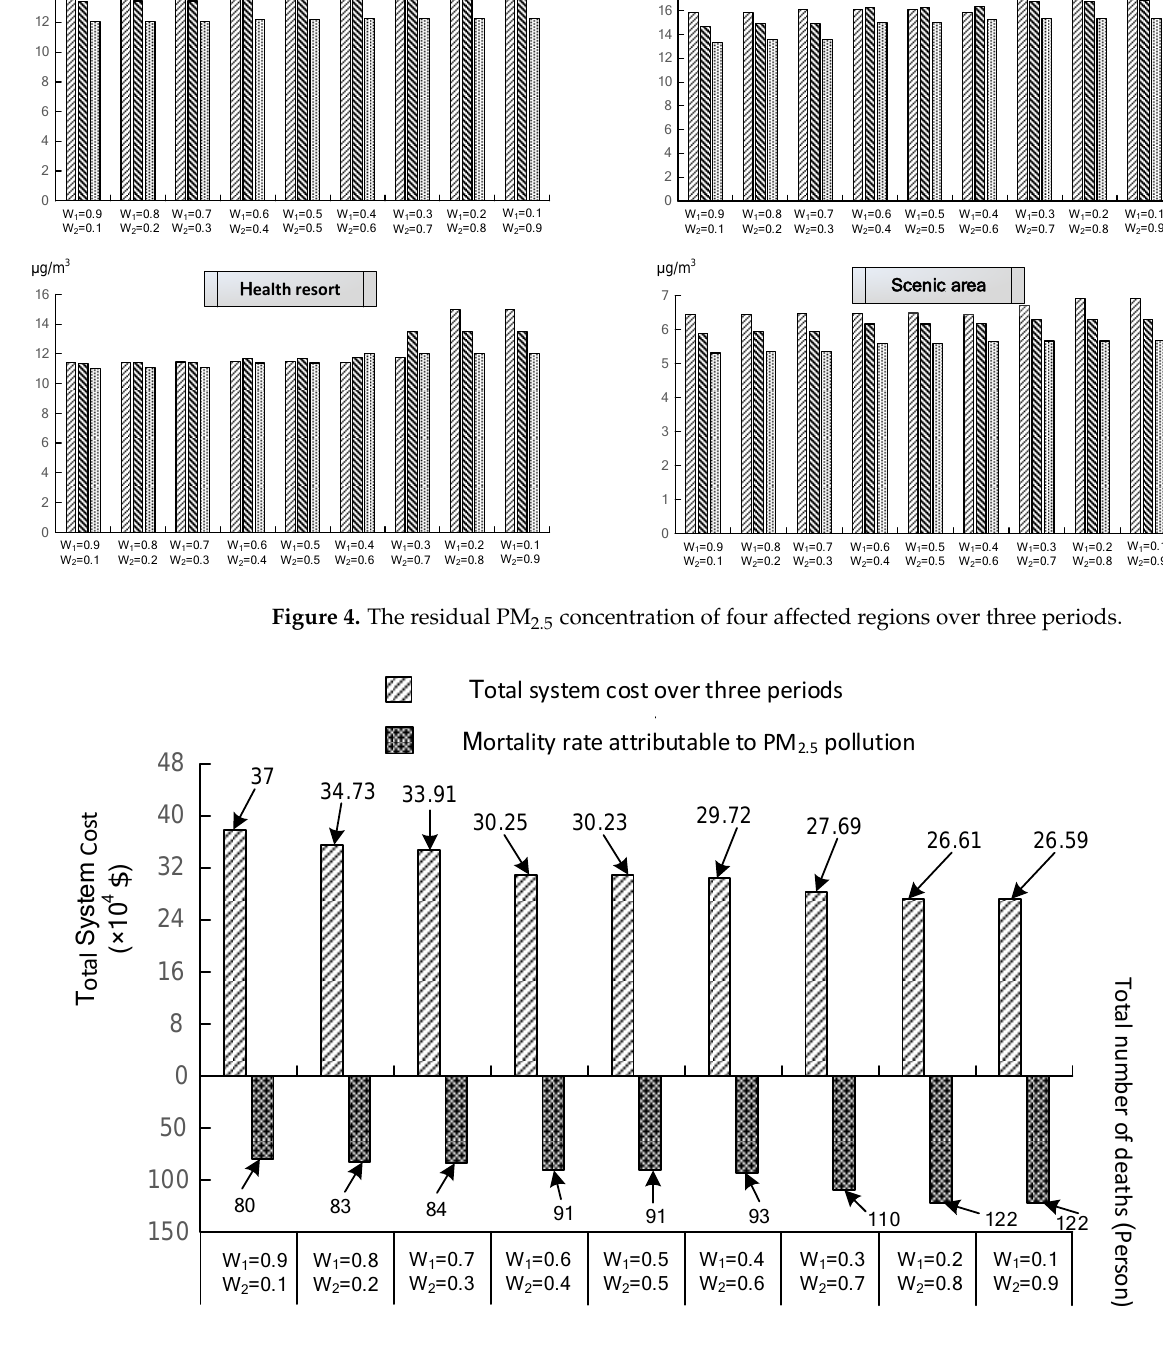
Figure 5. The comparison of two objective values under various weight combinations.